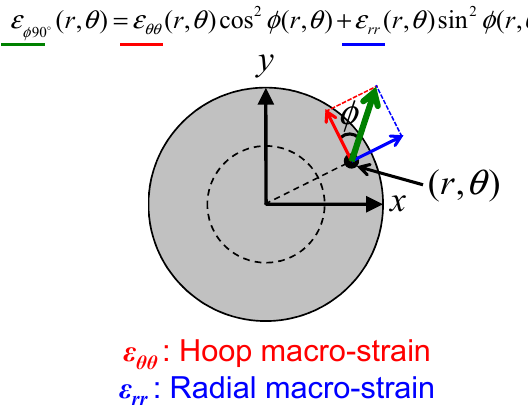
Figure 16. Macro-strain scalar components (hoop component ε θθ and radial component ε rr ) in the axial-symmetric VAMAS sample [54].